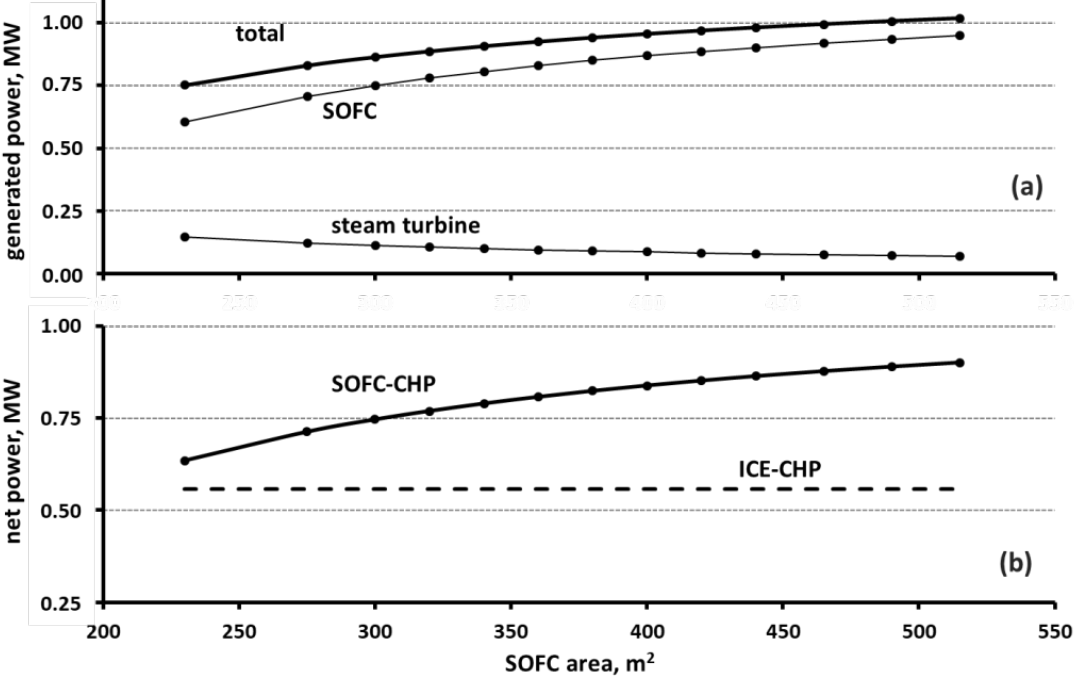
Figure 3. Biogas plant power generation and its dependence on the employed SOFC unit size, for 250 m 3 · h − 1 biogas production.